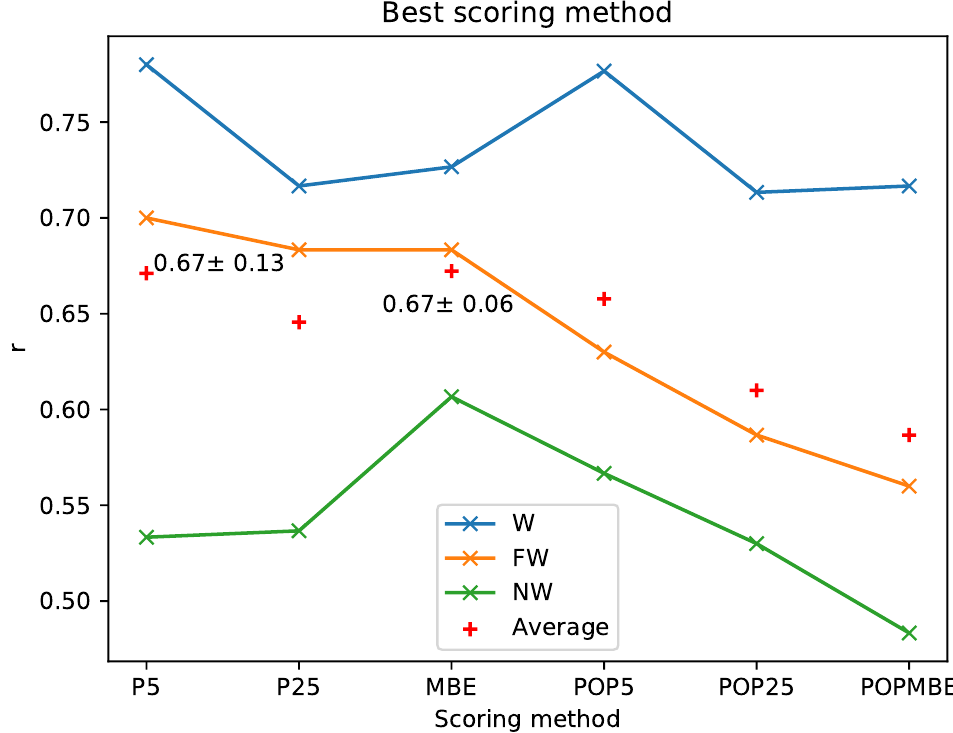
Figure 4. Average r of the three values obtained for each series of ligands for every scoring method. In the case of the fifth percentile and the mean binding energy (P5, MBE), the average with its standard deviation is indicated. No error bars are shown to simplify the visualization of the